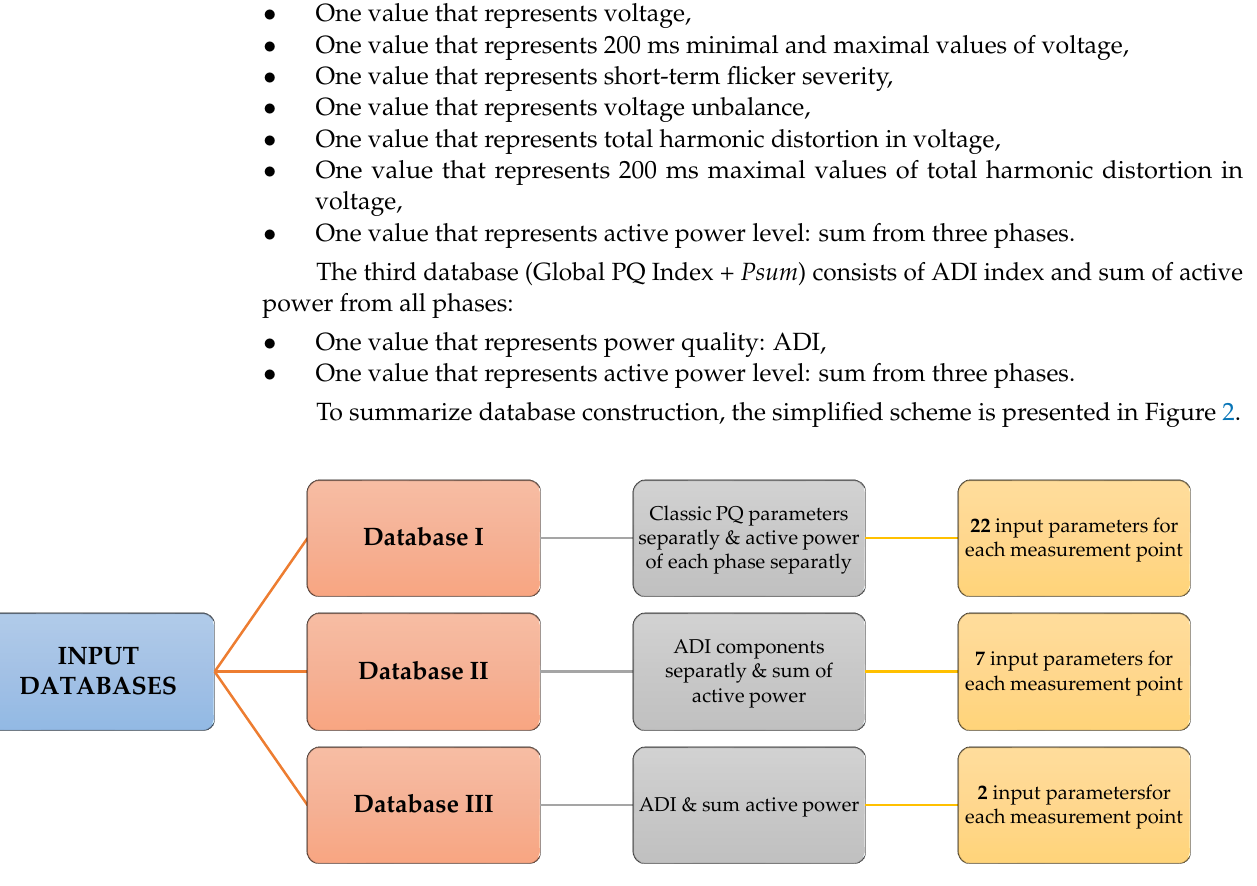
Figure 2. Simplified scheme of the proposed input databases.